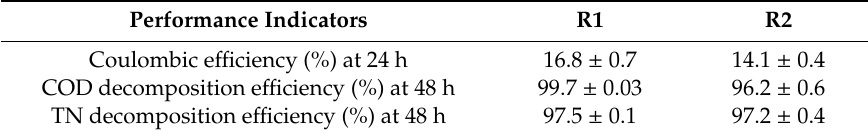
Table 2. Numbers of reads and operational taxonomic units (OTUs), along with values of alpha diversity index, Shannon’s diversity index, and Simpson’s diversity index for the microbial communities of different samples from the anodes of the bioelectrochemical system-trickling filter (BES-TF) reactors R1 and R2. PC: planktonic cells, Outer-Low: Outer biofilm of the lower part of the anode (submerged in wastewater), Outer-Up: Outer biofilm of the upper part of the anode (not submerged in the wastewater), Inner-Low: Inner biofilm of the lower part of the anode (submerged in wastewater), Inner-Up: Inner biofilm of the upper part of the anode (not submerged in the wastewater).